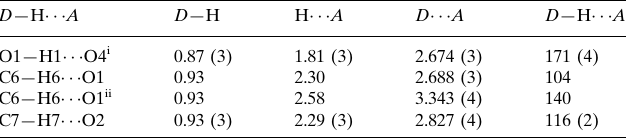
Hydrogen-bond geometry (A˚ , (cid:2)